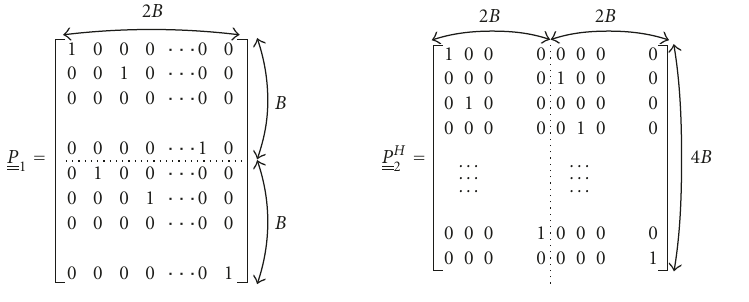
Figure 6: Permutation matrices P and P H .